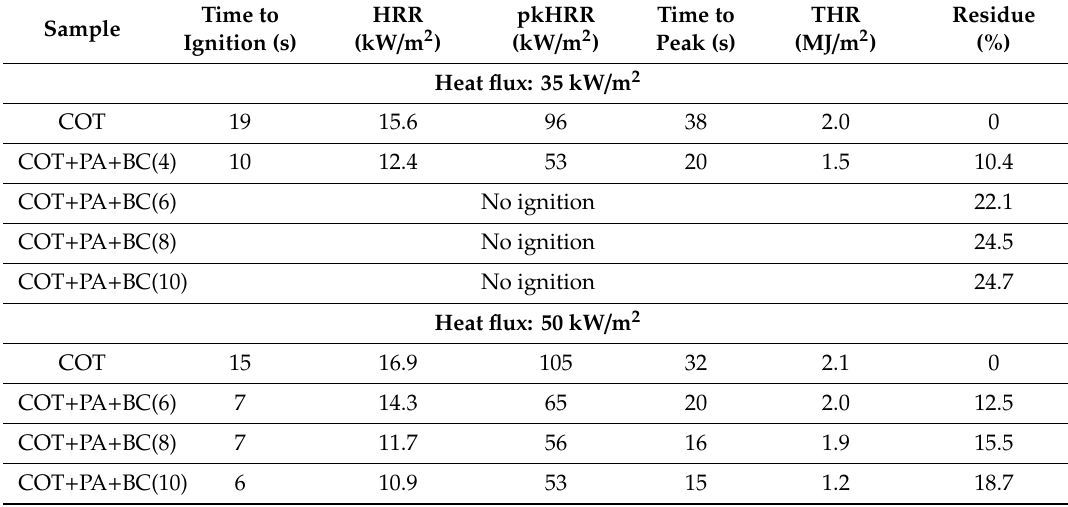
Figure 7. Heal Release Rate (HRR) vs. time curves for treated and untreated cotton fabrics (heat flux: 35 kW/m 2 ).